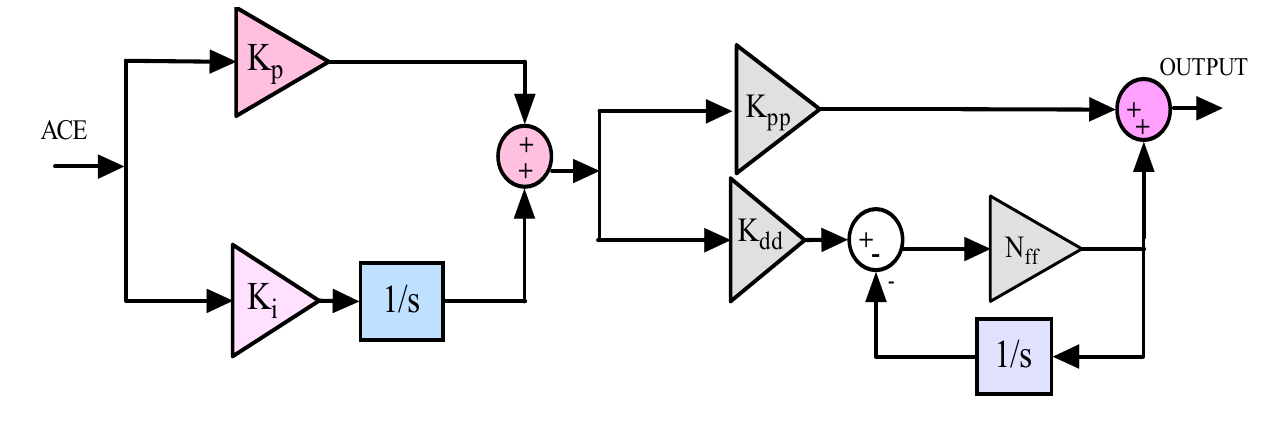
Figure 4. Configuration of proposed controller .